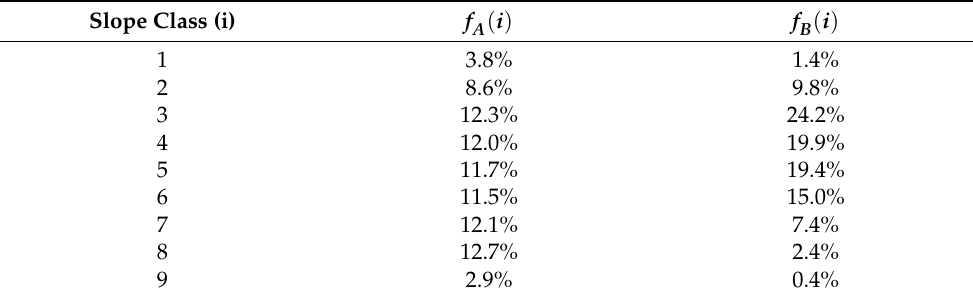
Table A5. The distribution of global maize harvested area in terms of slope.